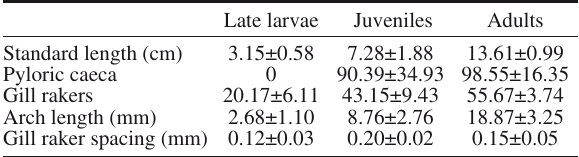
Table 2. – Means±Standard deviations of anatomical parameters of sardine.